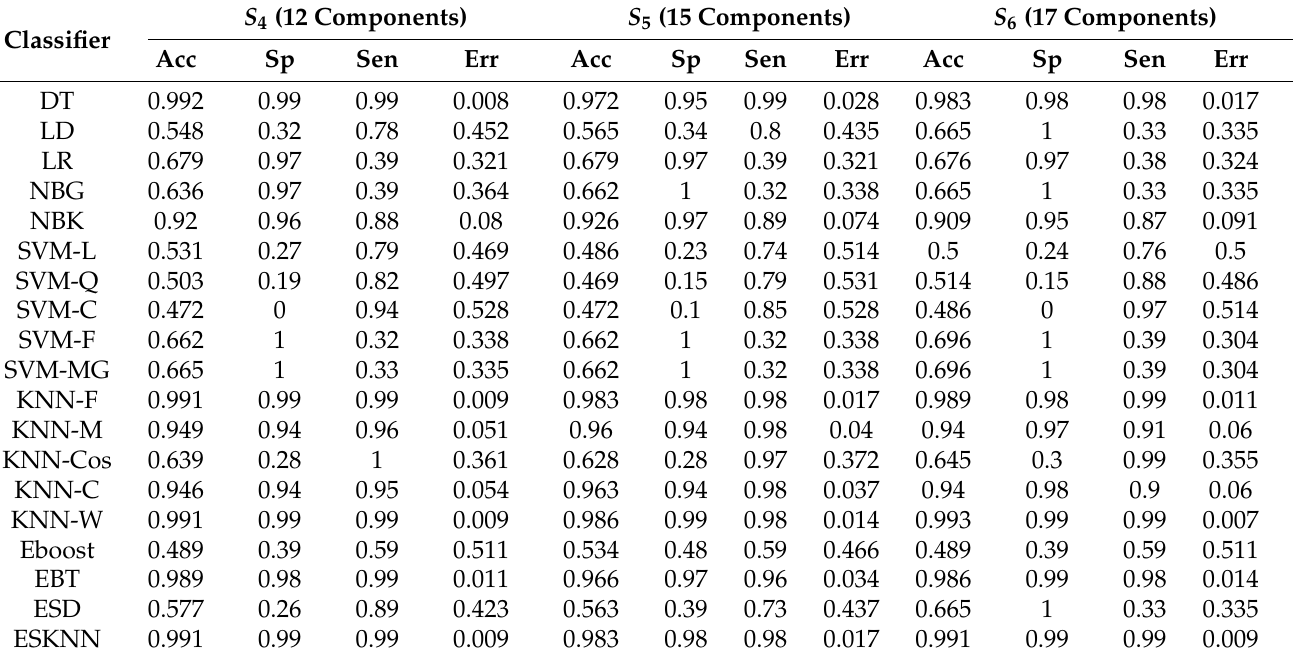
Table 13. Feature analysis table ( S 4 , S 5 , S 6 ) for method